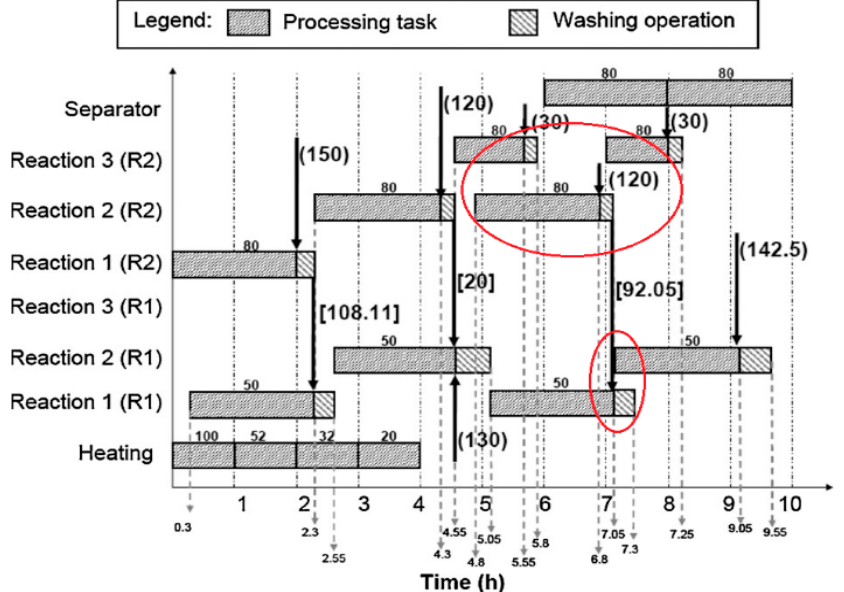
Figure 11. Reported Gantt chart from Majozi and Gouws [7] with overlapping time violation shown using red colored oval.